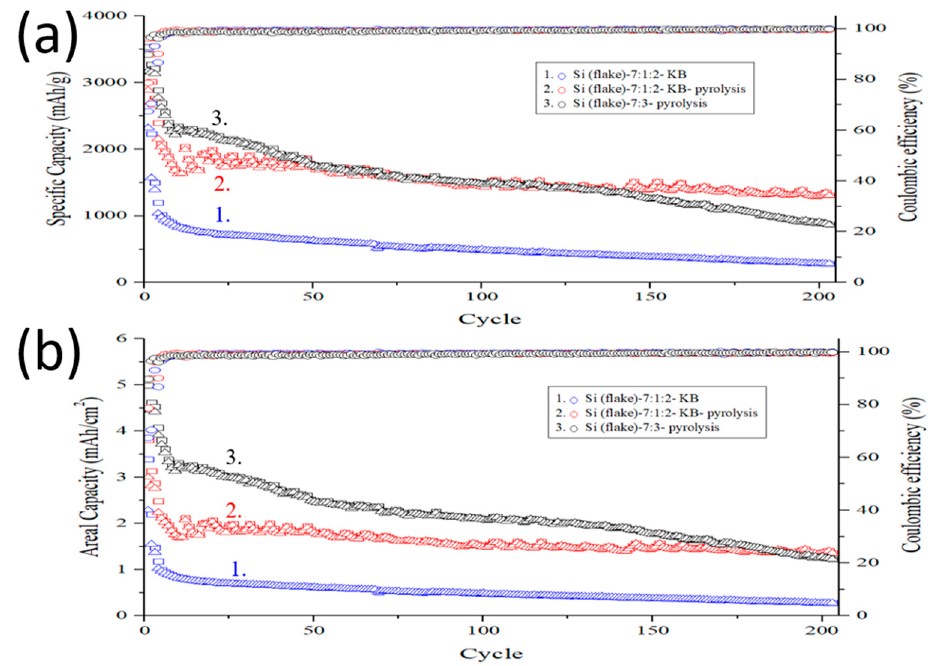
Figure 12. ( a ) Specific capacity and ( b ) areal capacity cycling performance of anodes made of (black, 3) silicon flakes–CMC/SBR = 70%:30% in weight ratio after pyrolysis; (red, 2) silicon flakes–KB–CMC/SBR = 70%:10%:20% in weight ratio after pyrolysis; (blue, 1) silicon flakes–KB–CMC/SBR = 70%:10%:20% in weight ratio without pyrolysis.